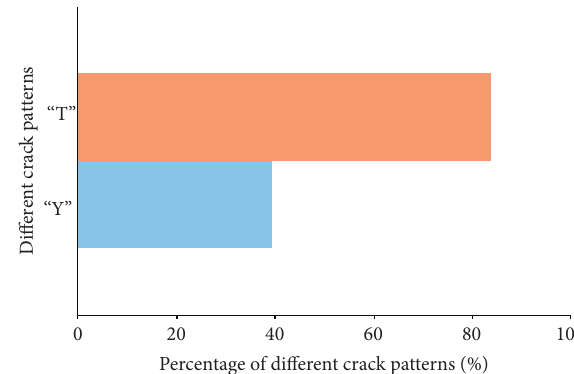
Figure 15: Percentages of different crack